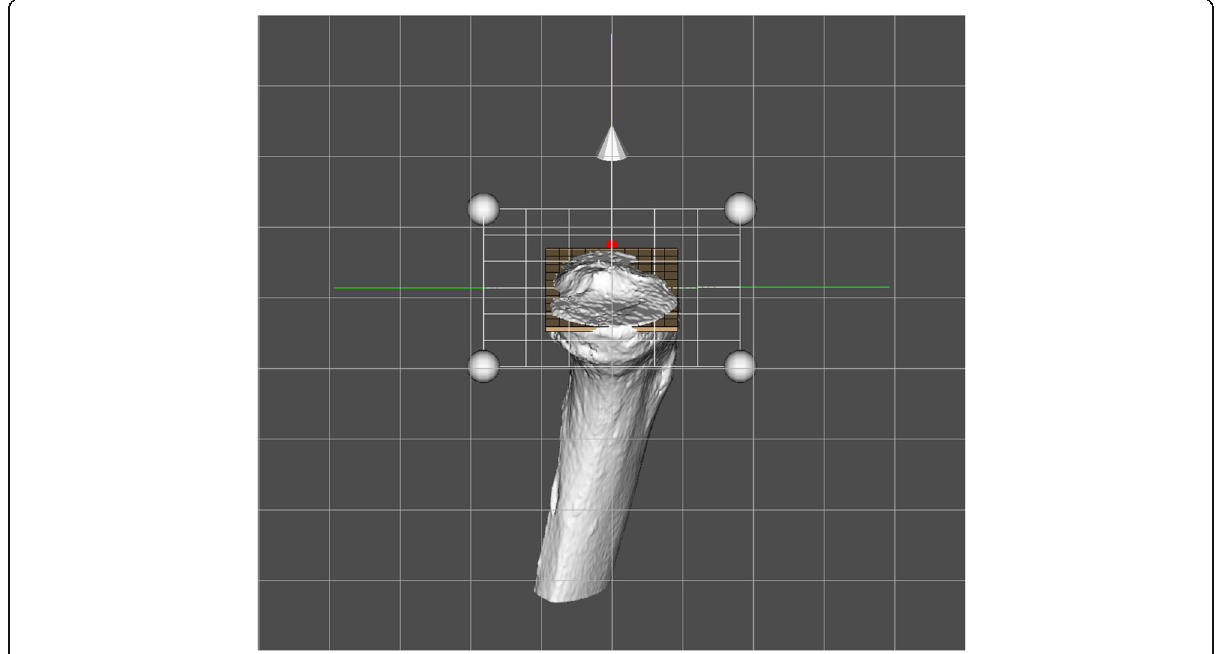
Fig. 1. A local coordinate system of the tibia using the CT-derived tibial model. Tibial coordinate system is embedded using a virtual rectangle fitted onto the tibial cross section at the top of the fibular notch level. Then, the fitted rectangle is translated superiorly to the bottom of the medial and lateral tibial